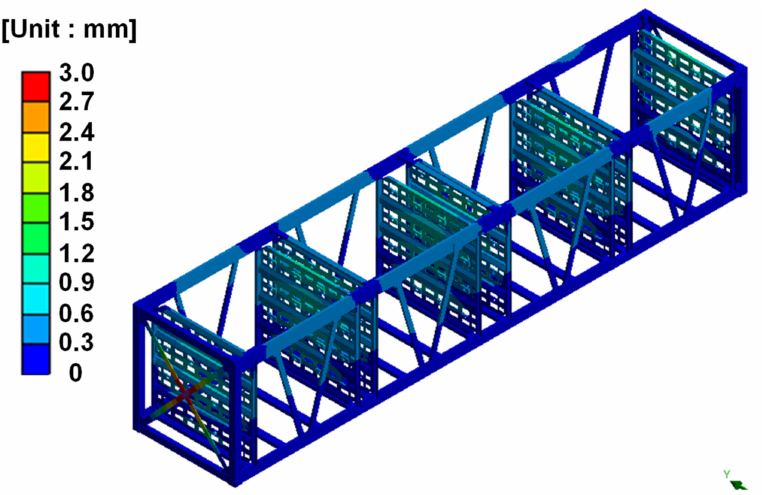
Figure 11. Maximum deformation result under pothole